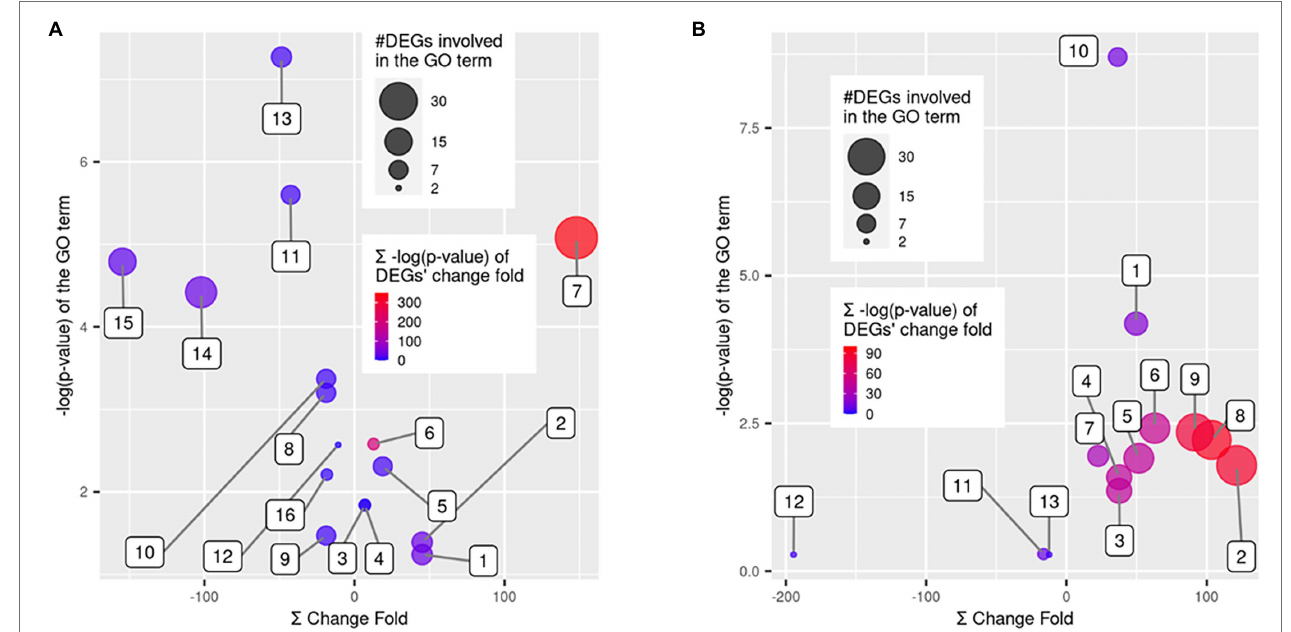
FIGURE 4 | GO term enrichment analysis for the differentially expressed genes (DEGs). Scatter plots show the False Discovery Rate (FDR)-corrected p values of GO term enrichment analysis using Fisher’s exact test vs. a sum of fold changes of the DEGs. The enriched GO terms were over-represented in DEGs as compared to the whole western hemlock reference transcriptome. Bubble sizes indicate the number of DEGs involved in each GO term, and bubble colors indicate a sum of the FDR-corrected p values for the statistical significance of DEGs’ fold changes. (A) GO terms enriched in resistant seedlings, including (1) terpenoid metabolic process, (2) terpenoid biosynthetic process, (3) cinnamic acid biosynthetic process, (4) cinnamic acid metabolic process, (5) benzene-containing compound metabolic process, (6) GDP-mannose 3,5-epimerase activity, (7) oxidoreductase activity, (8) steroid metabolic process, (9) response to wounding, (10) xylem and phloem pattern formation, (11) cellular respiration, (12) iron coordination entity transport, (13) electron transfer activity, (14) oxidoreductase activity, (15) transmembrane transporter activity, and (16) proton-transporting ATP synthase complex. (B) GO terms enriched in susceptible seedlings, including (1) DNA replication, (2) cellular component organization, (3) external encapsulating structure organization, (4) cell wall organization, (5) DNA-binding transcription factor activity, (6) hydrolase activity, hydrolyzing O-glycosyl compounds, (7) pectinesterase activity, (8) cell periphery, (9) plasma membrane, (10) MCM complex, (11) plant- type cell wall modification, (12) basic amino acid transport, and (13) killing of cells of other